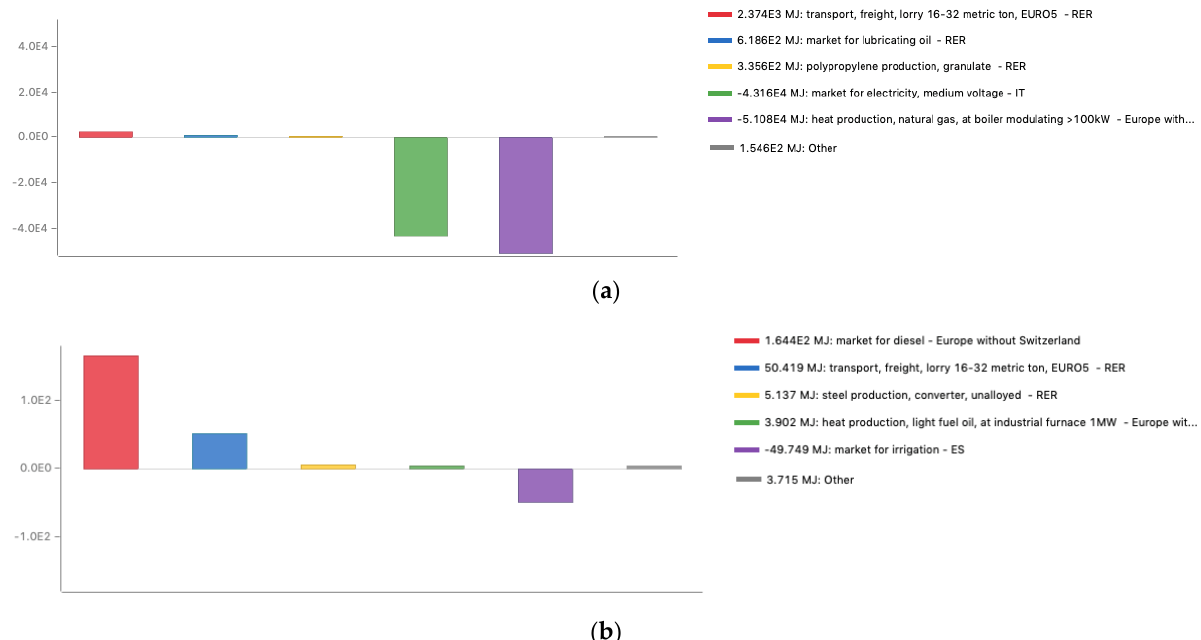
Figure 6. Depletion of abiotic resources—fossil fuels: top 5 contributions impacting category results: ( a ) Cradle-to-grave analysis; ( b ) Downstream process.